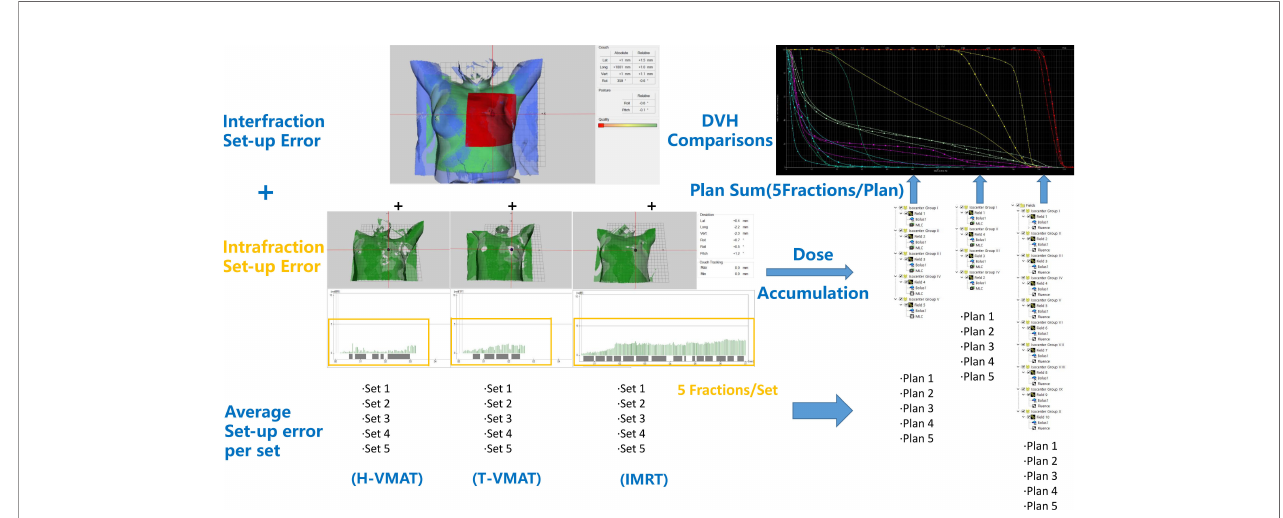
FIGURE 3 | The work fl ow used to generate the SGRT-based setup errors and dose accumulation is shown. First, non-rigid algorithm was used for interfraction setup error analysis. Then we subdivided the intrafraction setup error of each fi eld and each technique divided 25 fractions into 5 sets (5 fractions per set). Furthermore, sum up the average setup error for each set. Finally, the setup errors imported to TPS and converted each fi eld into an isocenter group, then accumulated and compared dose. In the DVH comparisons fi gure, — shown as T-VMAT, — shown as H-VMAT, — shown as